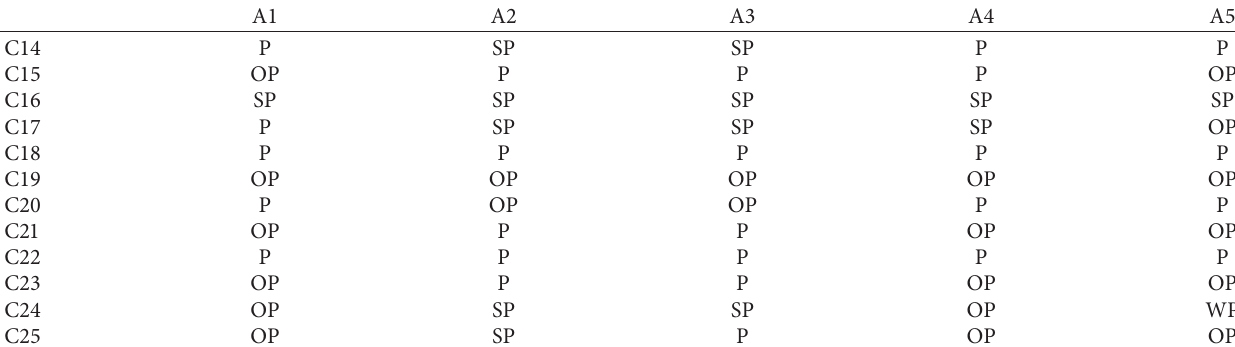
Table 10: Linguistic terms of decision-maker’s viewpoint in environment criteria.